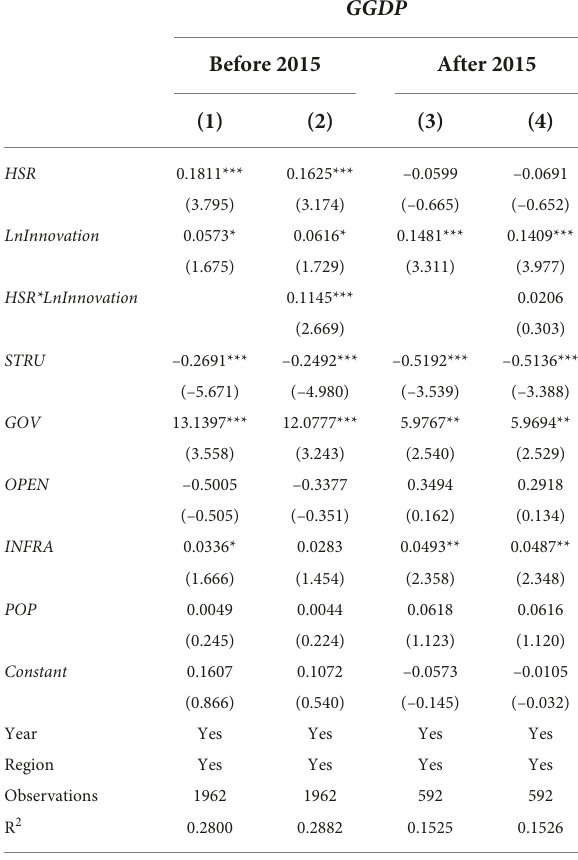
TABLE 5 The regression results of government